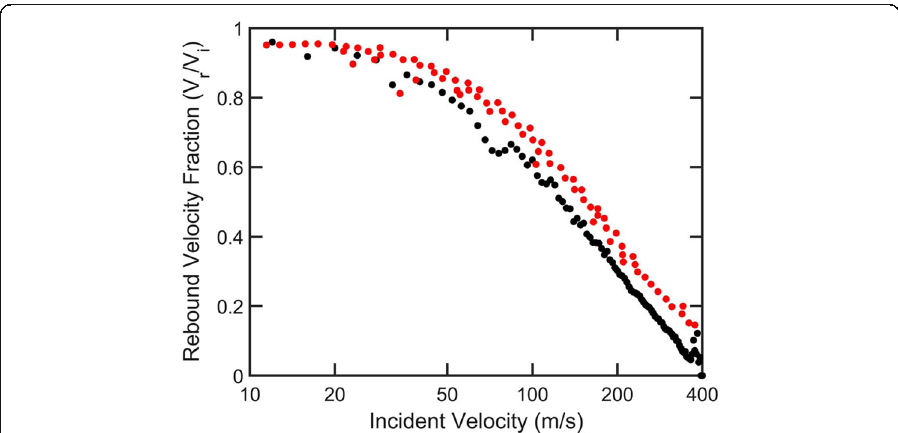
Fig. 14 Coefficient of restitution data for 990 nm PSLs at normal incidence on silicon, presented with incident velocity grouped in 4 m/s bins then averaged (mean), black circles. Any data outside of one standard deviation from the mean for each bin were removed. Created from 3592 measured events. The data are compared to data reported by Dahneke (red circles) in ref. [53] for 1.27 μ m PSLs at normal incidence on fused